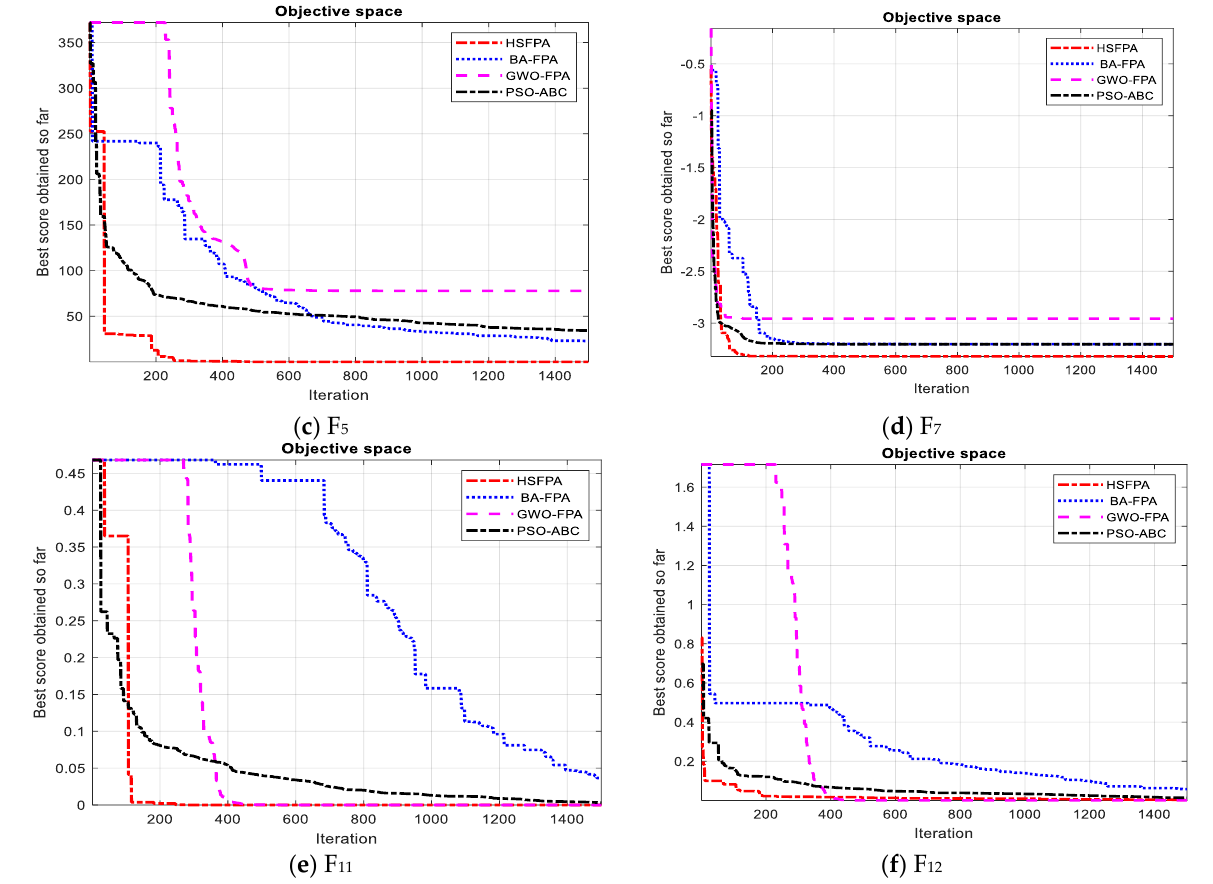
Figure 4. Comparative curves of the evaluated performance of the proposed HSFPA with the FPA, MFPA, and PSO algorithms for the testing function of F 3 , F 4 , F 5 , F 7 , F 11 , F 12 as in subfigures: ( a – f ), respectively.